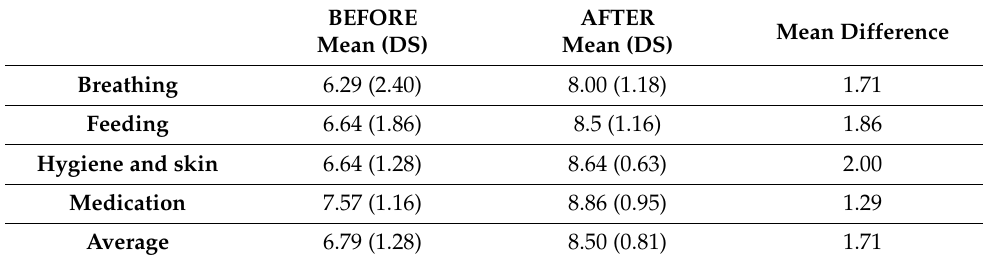
Table 6. Mean score in self-perception of knowledge before and after the training program, and the mean